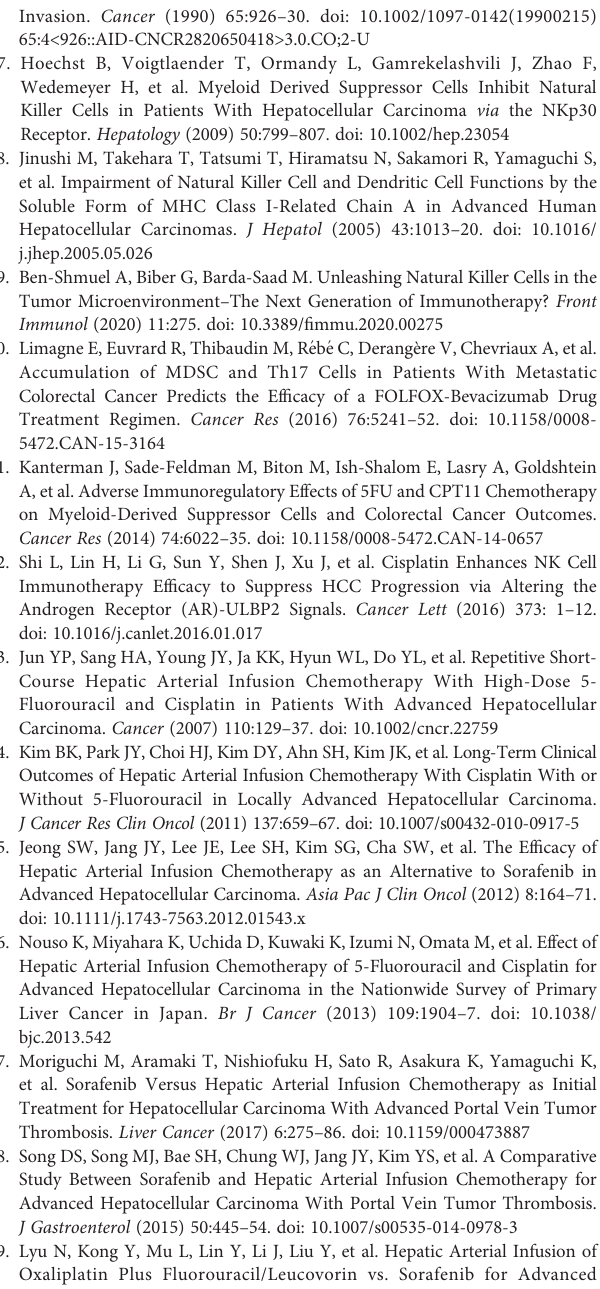
Supplementary Figure 1 | Immunopro fi ling during and after treatment. Graphs in Figure5arerepresentedasinlineanddotplotformat. (A) Percentagesofperipheral NK cells with CD3 - CD56 + before and after locoregional NK cell infusion. (B) The cytotoxic activity of PBMCs against K-562 cells at effector to a 10:1 E:T ratio. (C – E) The serum cytokine levels of IFN- g , IL-10, and TGF- b